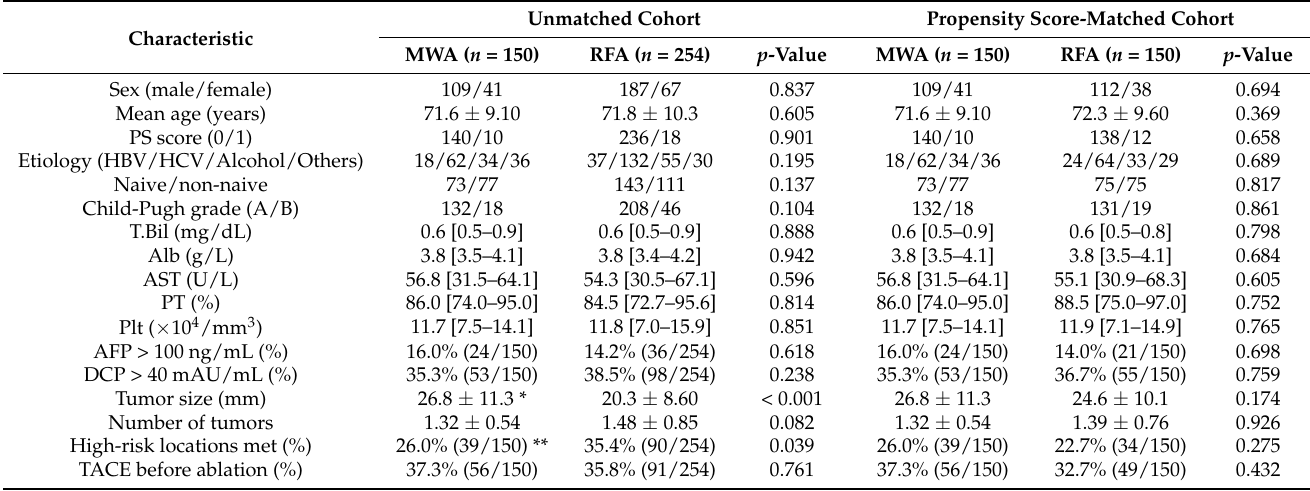
Figure 1. Study flowchart. MWA, microwave ablation; RFA, radiofrequency ablation. Table 1. Comparison of the MWA and RFA groups in the unmatched and propensity score-matched cohorts.